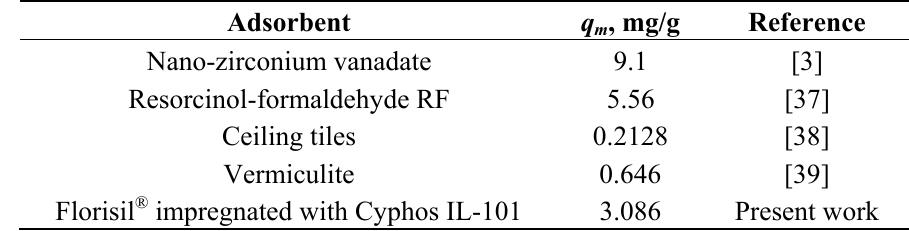
Table 3. Adsorption capacity of various adsorbents in the process of Cs + removal from aqueous solutions.